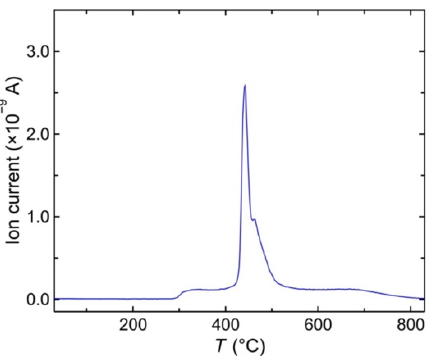
Figure 6. Quadrupole mass spectrometry of H 2 during heating of the S-2-2 which is prepared by twice heat treatment at 1000 °C for 10 h and subsequent hydrogenation with CaH 2 at 520 °C for 120 h.